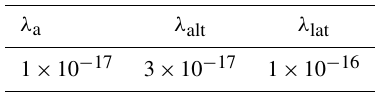
Table 1. Regularisation parameters as used in the NO retrieval from SCIAMACHY limb